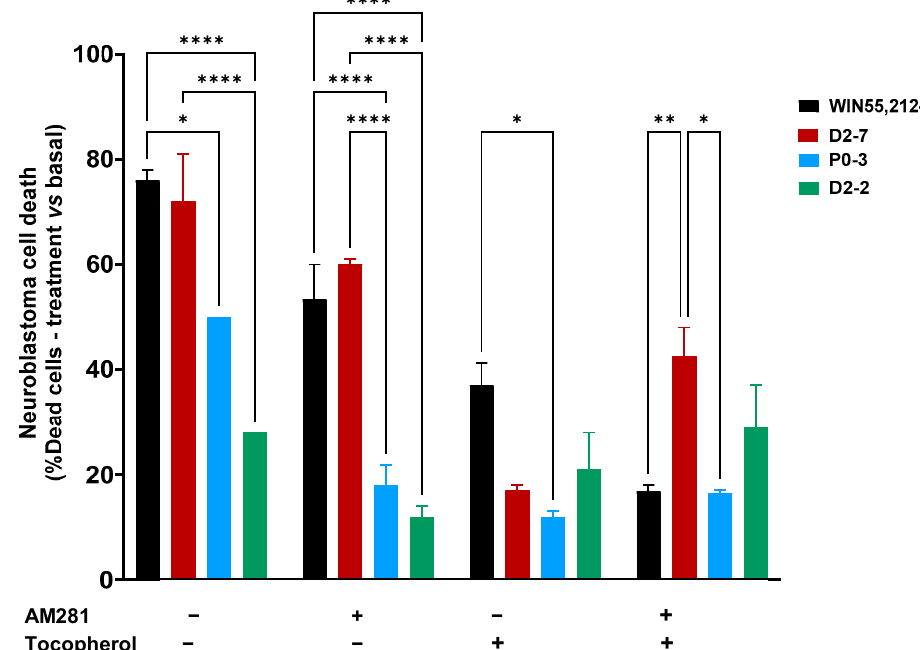
Figure 3. Neuroblastoma cell death at 24 h, after different treatments, both with the presence and absence of synthetic cannabinoid WIN55,212-2, and with a variety of Cannabis plant extracts (D2-7, P0-3, and D2-2), with or without antioxidant pre-treatment. The two-way ANOVA with Tukey’s post-hoc was performed with α set as 0.05, two-tailed. p -value < 0.05 (*); <0.01 (**); <0.0001 (****).